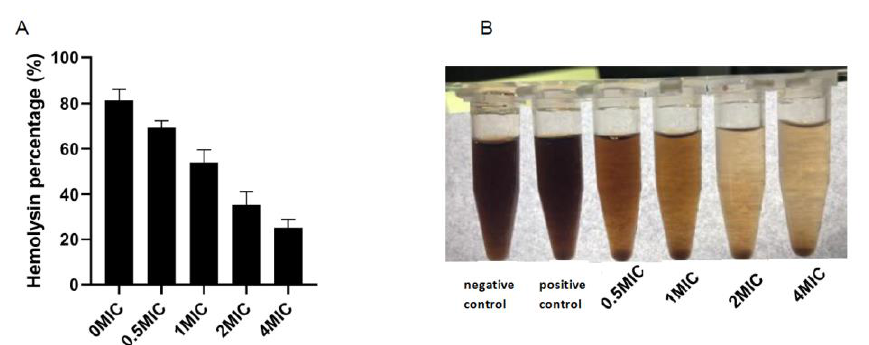
Figure 3. Lemon verbena essential oil inhibits the hemolytic effect of Pseudomonas D4 on sheep red blood cells. ( A ) Hemolysis assay of Pseudomonas D4 treated with different concentrations of lemon verbena essential oil (0 × MIC, 1/2 × MIC, 1 × MIC, 2 × MIC, and 4 × MIC). ( B ) Hemolysis assay of Pseudomonas D4 treated with different concentrations of lemon verbena essential oil (0 × MIC, 1/2 × MIC, 1 × MIC, 2 × MIC, and 4 ×